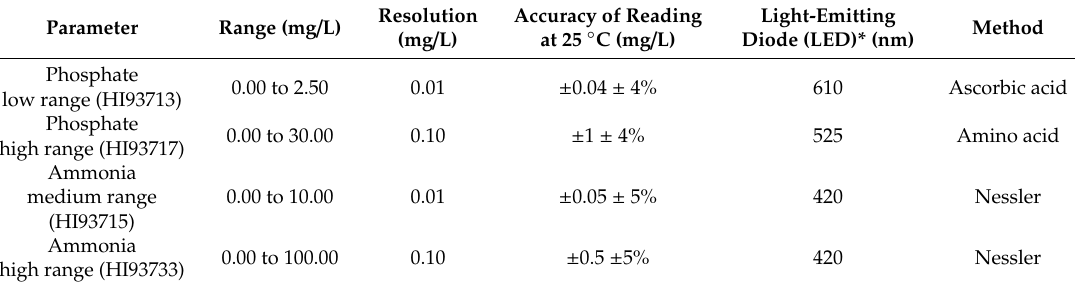
Table 3. Technical specifications for HANNA HI-83,399 reagent test